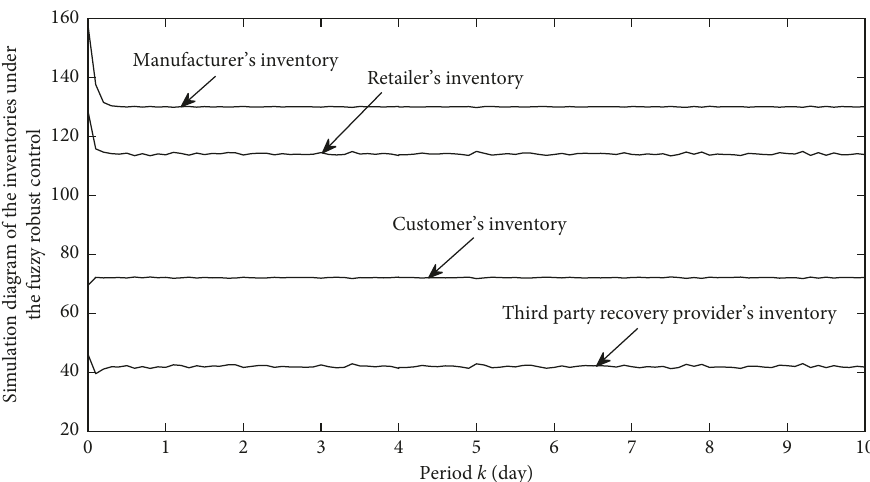
Figure 6: Simulation diagram of the inventories under FRC (unit: × 10 3 sets).